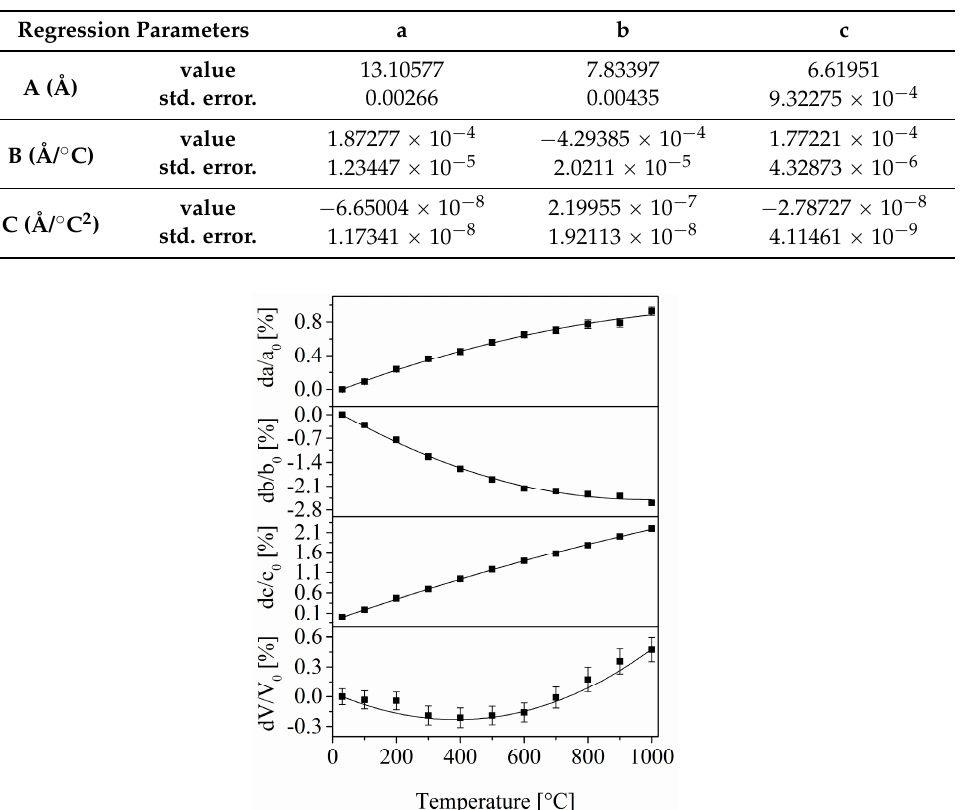
Table 1. Regression parameters describing the temperature dependence of the lattice parameters a, b, and c of the compound Ba 0.5 Sr 0.5 Zn 2 SiGeO 7 using a polynomial of the form: y(T) = A + BT + CT 2 .